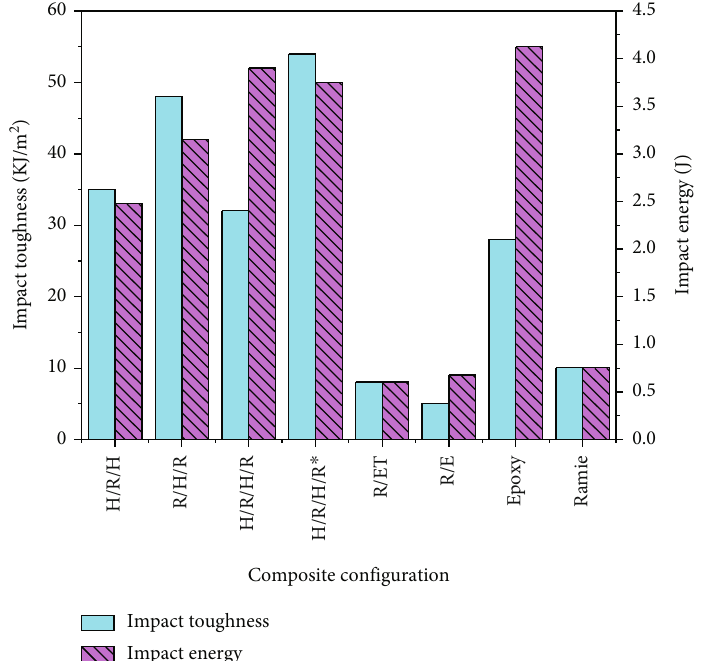
Figure 7: Impact energy and toughness of R/H hybrid composites, R/E, pure epoxy, and H/E by Charpy impact